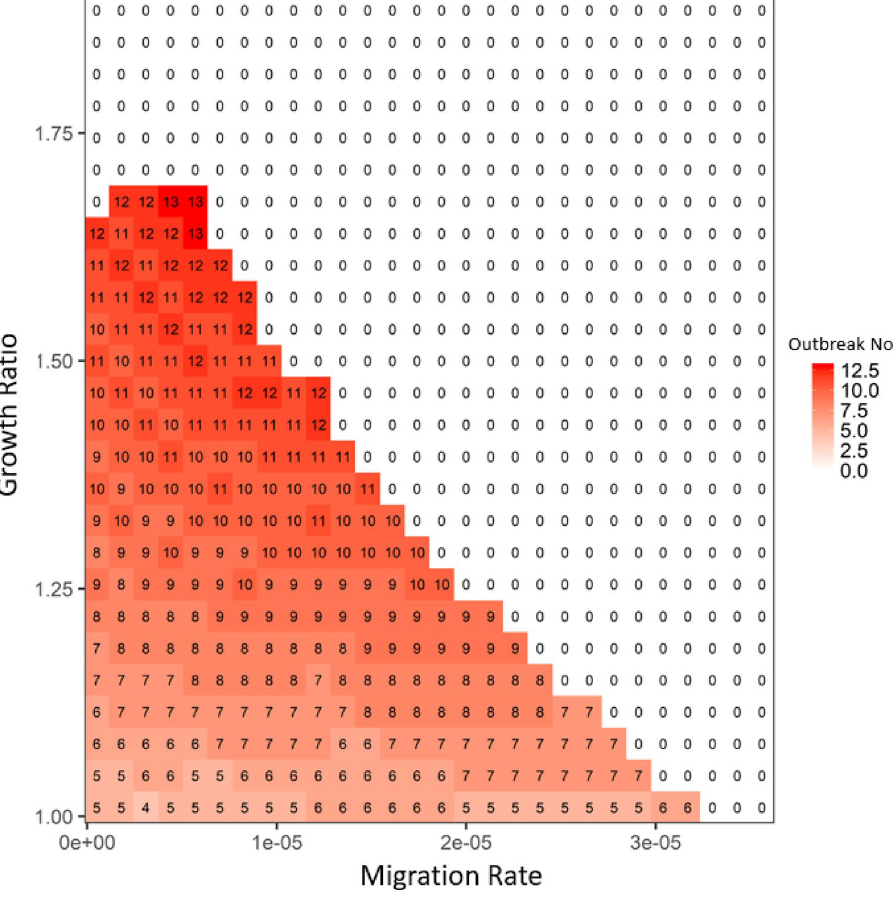
Figure 4. The average disease outbreak numbers in the last 25 generations (total simulated generations are 50) under the influences of growth ratio and migration rate for Robust type at patch #30, where robust type provides the baseline growth rate (in the absence of infection: i.e., rR ). The color trend with numbers represent the trend of outbreak numbers: from blue to white to red, outbreak numbers increase. All the other parameters are: r R = 0.15, r Wd = r Rd = 0.01, r Wr = r Rr = 0.2, α W = α R = 0.05, μ W = μ R = 0.0005, γ W = γ R = 0.05, β RR = β WR = 0.000005 and β RW = β WW = 0.0001. In focal patch #1, the initial susceptibles of both types are 200, infecteds are 5, and recovereds are 0. Other patches show similar